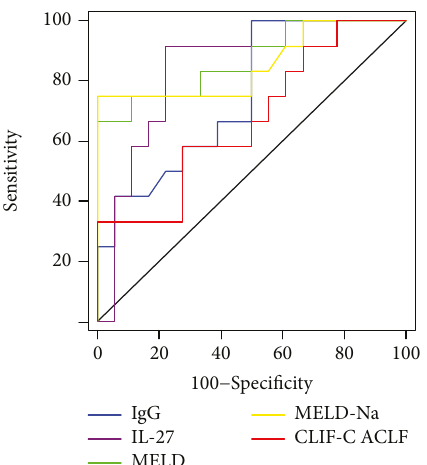
Figure 5: Accuracy of IgG levels was compared to other parameters in predicting the 3-month mortality of HBV-ACLF patients. The area under the ROC curve (AUC) for IgG levels was 0.752 (95% con fi dence interval: 0.562-0.891, P = 0 005 ). Interestingly, no signi fi cant di ff erences existed between AUC values obtained using IgG levels and those obtained with IL-27 levels (0.824, P = 0 531 ), MELD score (0.870, P = 0 320 ), MELD-Na score (0.854, P = 0 433 ), or CLIF-C ACLF score (0.671, P = 0 536 ) in HBV-ACLF